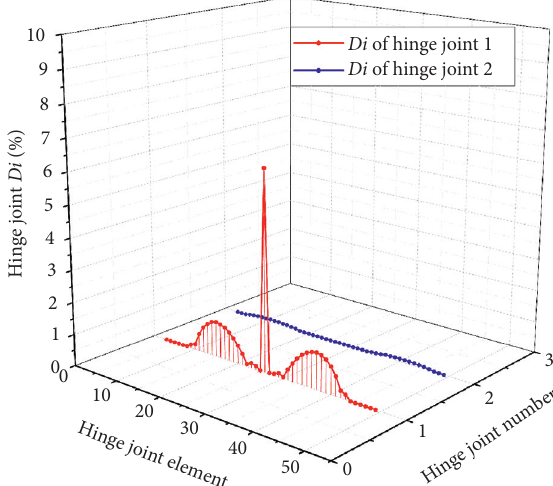
Figure 7: Calculation results of damage degree of hinge joints for case study 1.